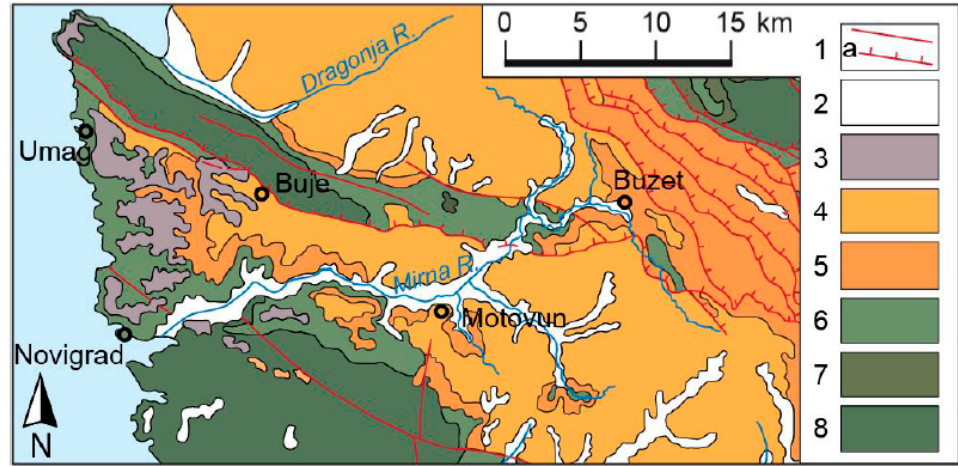
Figure 8. A geological map of Istria (1. Fault, 1a. Thrust, 2. Quaternary deposits (mainly Holocene), 3. Terra rossa deposits (Holocene), 4. Flysch deposits (Eocene), 5. Liburnia deposits, Foraminiferal limestone, and transitional deposits (Paleocene, Eocene), 6. Rudist limestone (Cretaceous), 7. Dolomite and breccia (Cretaceous), 8 Limestone and dolomite (Cretaceous), 9. Limestone and dolomite (Jurassic)) (taken from [31]).